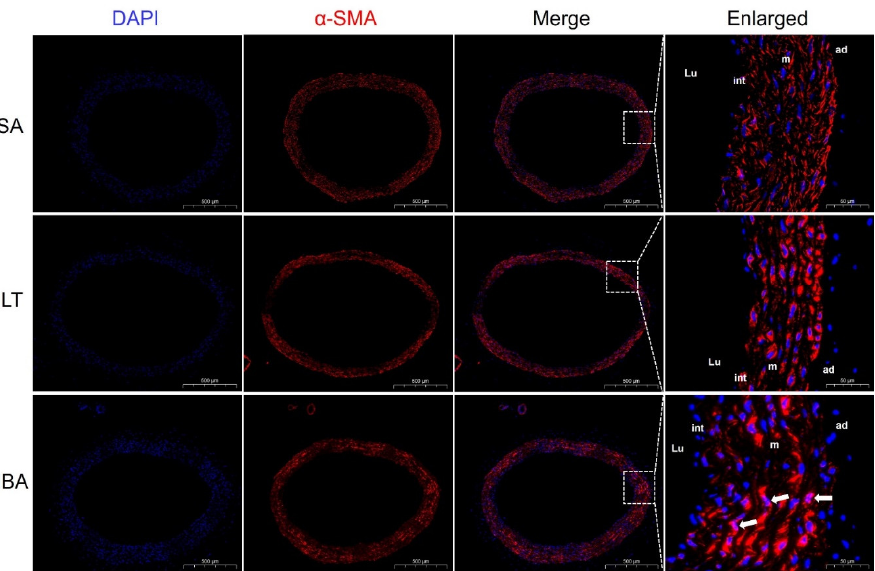
Figure 5. Immunofluorescence staining of α-SMA in the smooth muscle of thoracic aorta. DAPI (blue) labels the nucleus, and CY3 (red) labels α-SMA. The scale in left column = 500 μm. The scale in right column = 50 μm. The white arrows are nuclear translocation changes. SA: summer active, LT: late torpor, IBA: interbout arousal, Lu: lumen, int: intima, m: media, ad: adventitia.